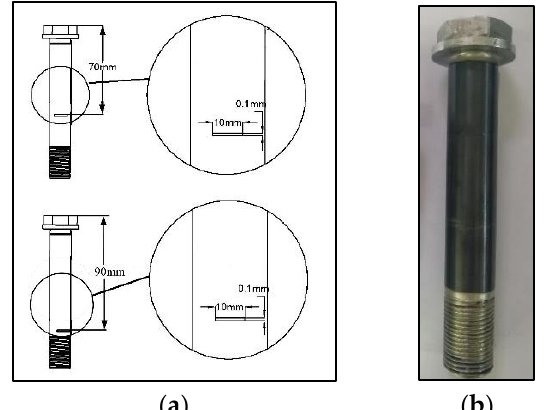
Figure 6. Helicopter hub damper bolts and artificial grooves. ( a ) Main parameters of grooves and ( b ) bolt.